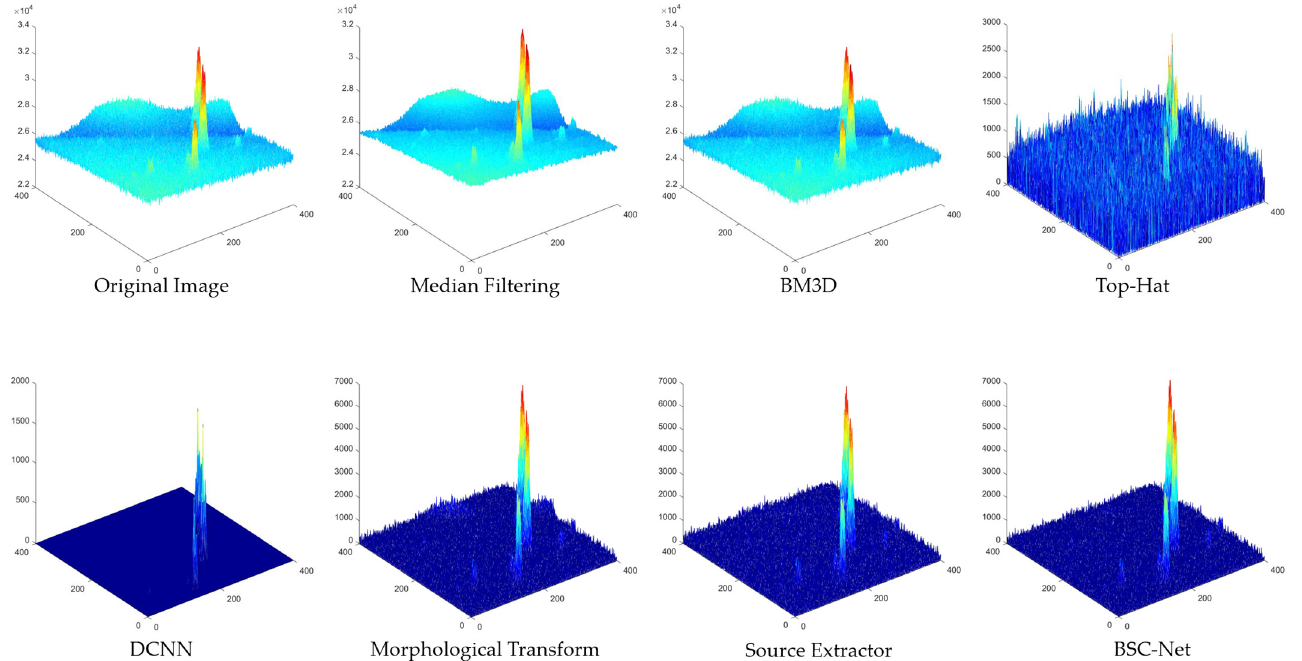
Figure 13. Grayscale image of cloud occlusion stray light in different algorithms.